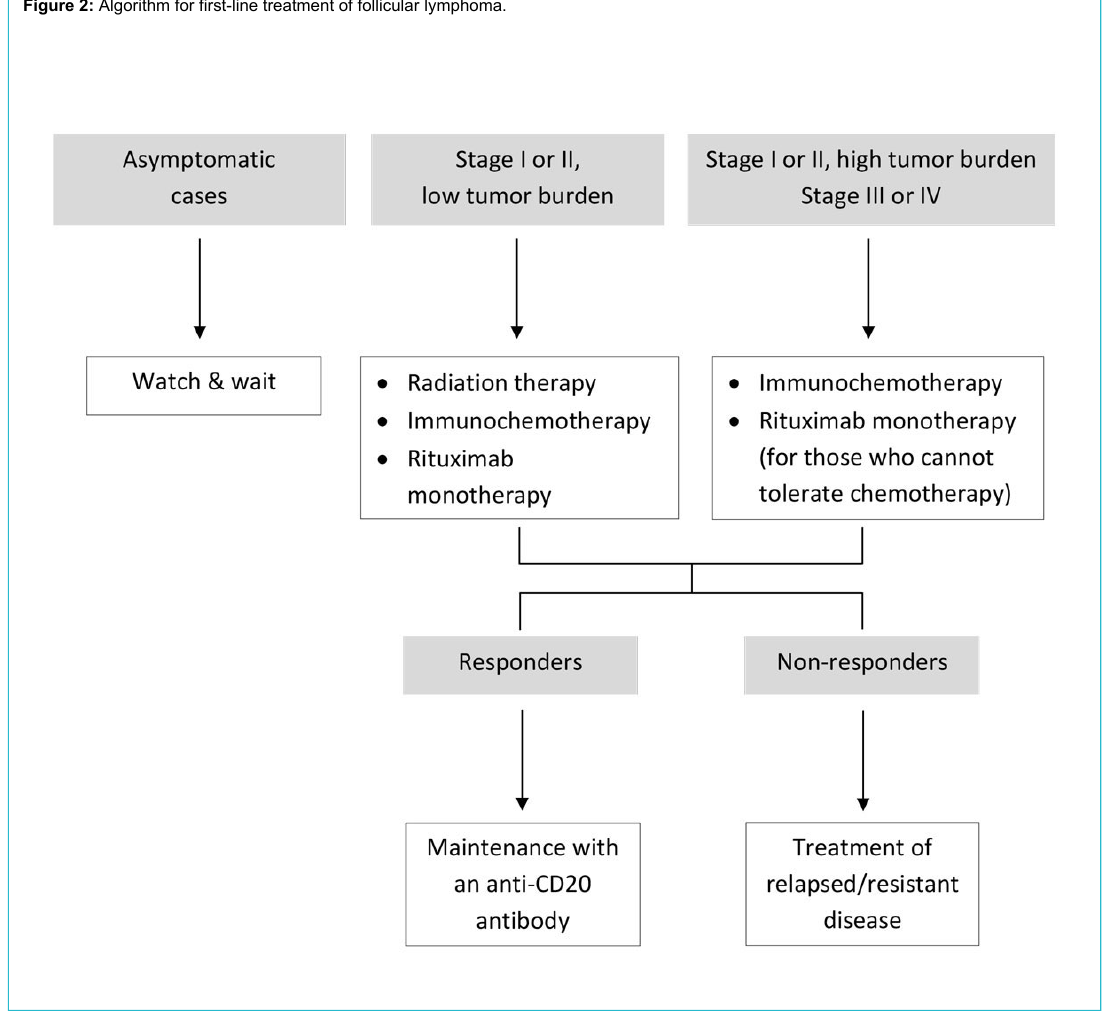
Figure 2: Algorithm for first-line treatment of follicular